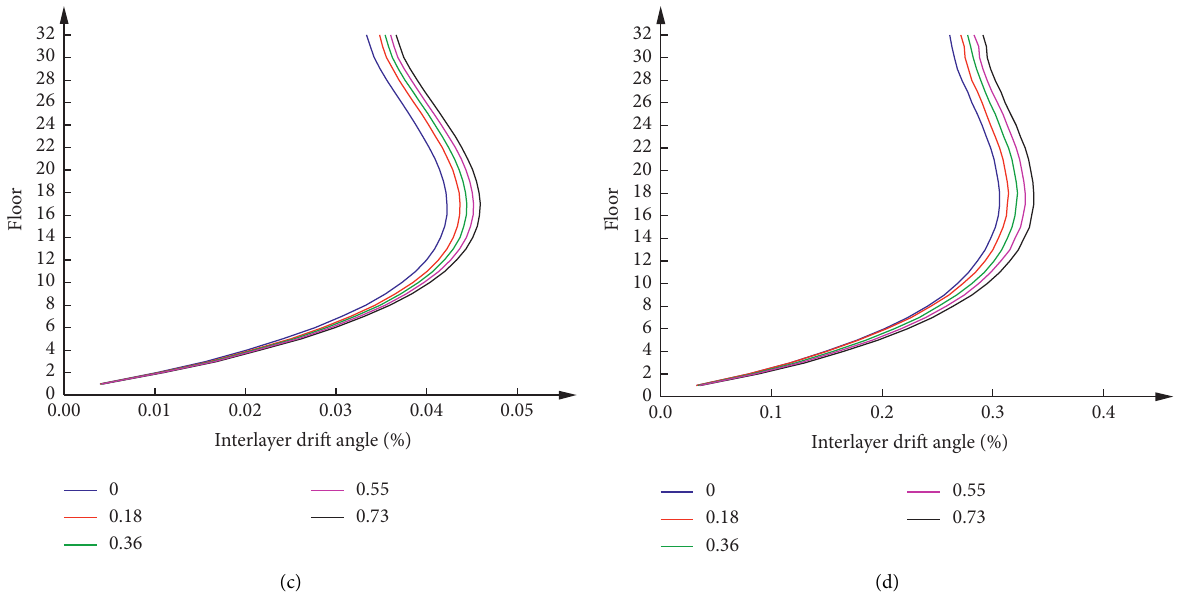
Figure 19: Effect of unbonded level on storey drift (a, b) and interlayer drift angle (c, d) in Y direction. (a) Frequent earthquake. (b) Severe earthquake. (c) Frequent earthquake. (d) Severe